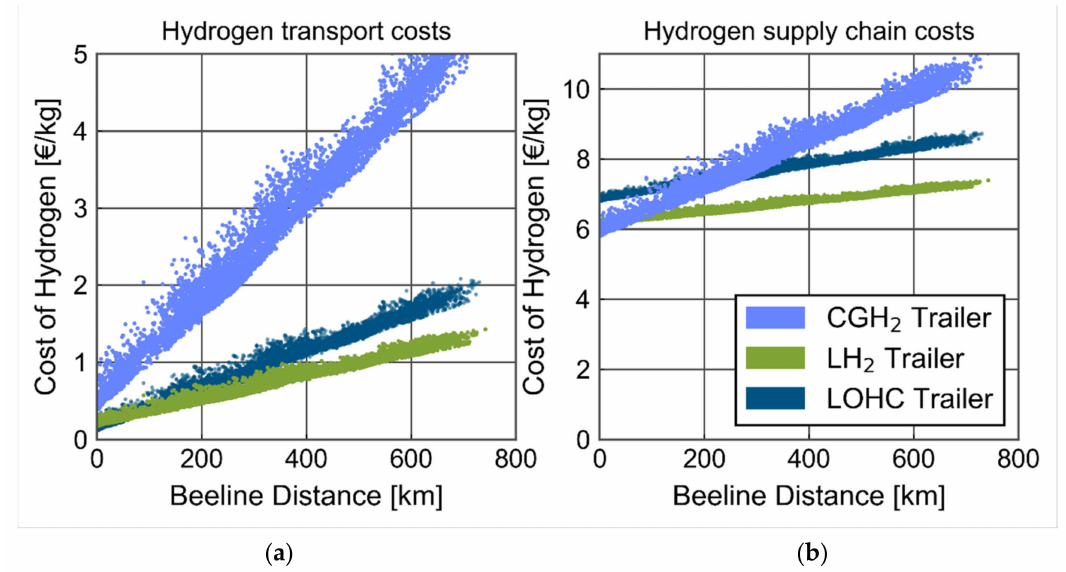
Figure 5. Hydrogen transport costs ( a ) and supply chain costs ( b ) of CGH 2 , LH 2 and LOHC as a function of the distance between the production site and the fueling station.